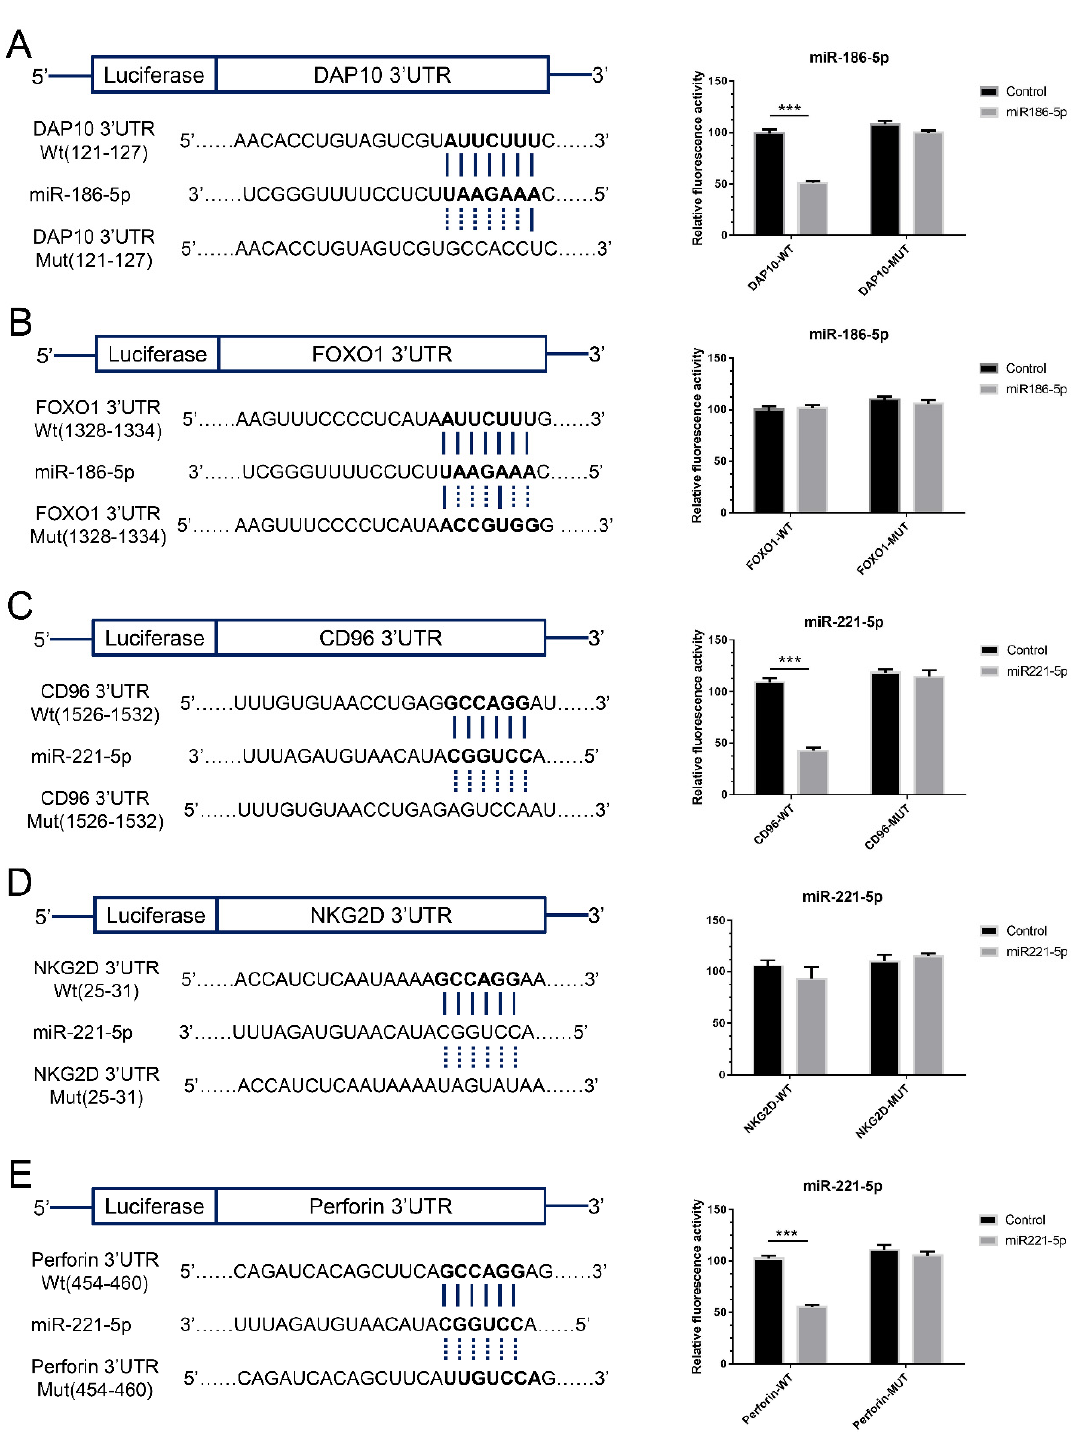
Figure 6. The pairing relationship of miRNAs and target genes. ( A ): The binding site and Dual-Luciferase reporter assay of miR-186-5p matched to DAP10 genes. ( B ): The binding site and Dual-Luciferase reporter assay of miR-186-5p matched to FOXO1 genes. ( C ): The binding site and Dual-Luciferase reporter assay of miR-221-5p matched to CD96 genes. ( D ): The binding site and Dual-Luciferase reporter assay of miR-221-5p matched to NKG2D genes. ( E ): The binding site and Dual-Luciferase reporter assay of miR-221-5p matched to Perforin genes. *** t test, p < 0.001. Due to the low transfection efficiency of the routine method on NK cells, the SV-HUC-1 derived exosomes were employed to carry miRNA mimic and transfect NK cells. After 48 h transfection, the content of miRNA in NK cells was evaluated by the q-PCR method. It was shown that the content of miR-221-5p and miR-186-5p were sig-